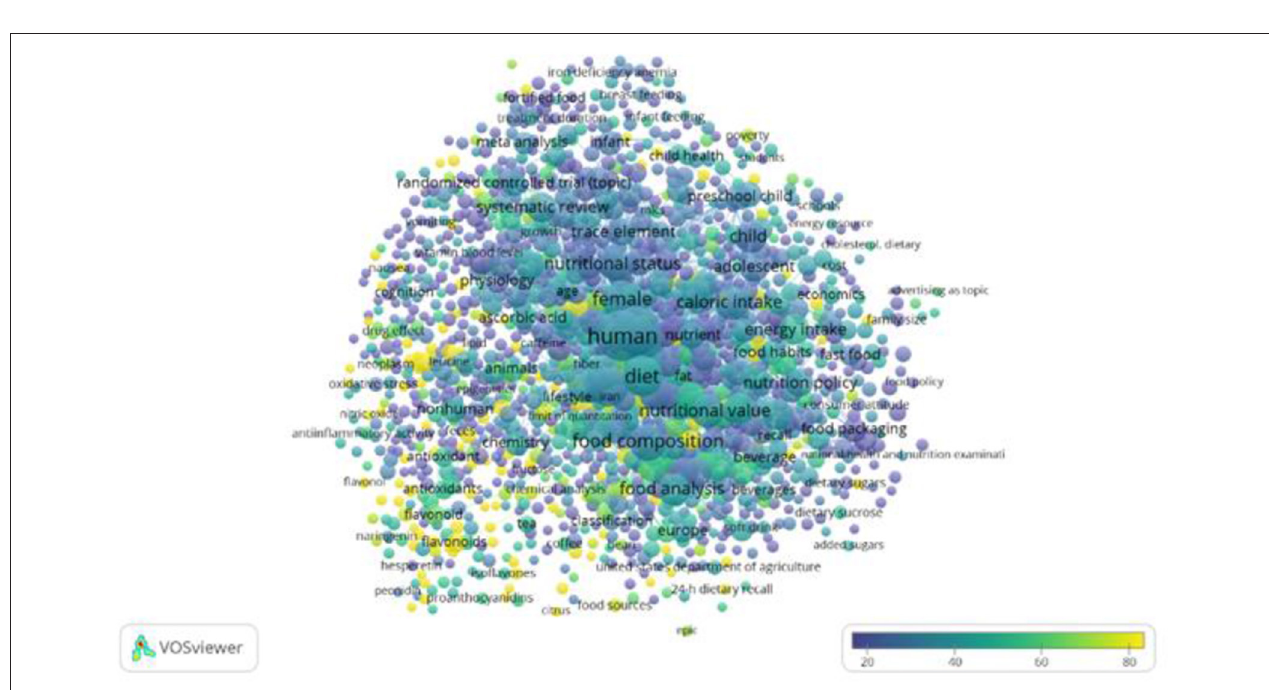
FIGURE 4 | Term map for search database, food, nutrition, health, composition, nutrient, bioactive compound, bioactive component, bioactive molecule, dietary supplement relationships. Bubble color represents the citations per publication (CPP). Two bubbles are closer to each other if the terms co-appeared more frequently. Based on data from Scopus and elaborated by VOSviewer